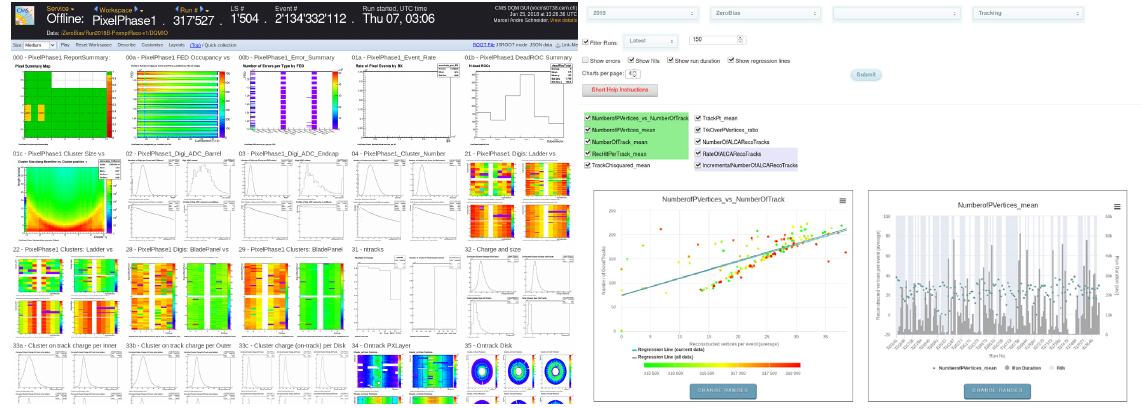
Figure 2. The user interface of DQMGUI (left) and historic DQM